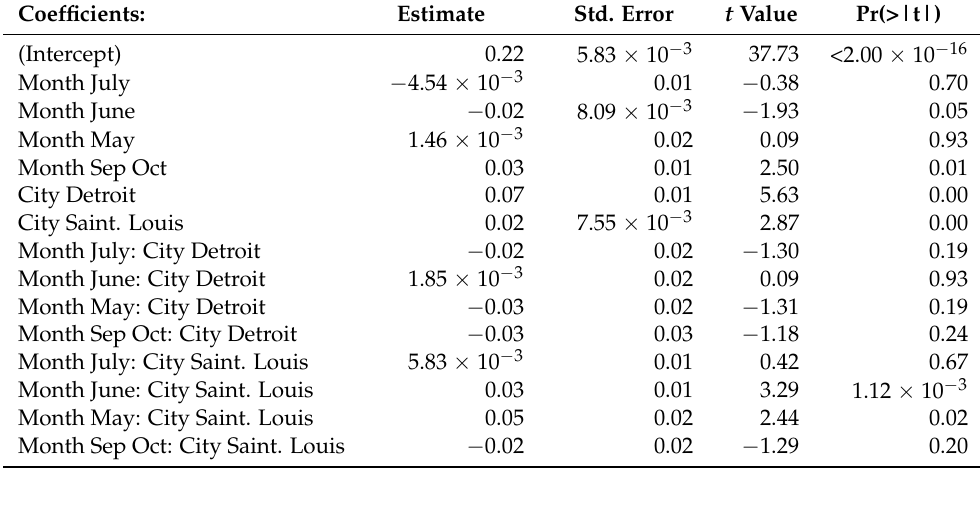
Table 4. The results of the linear model with head width as the response variable and month and city as interacting fixed effects indicate significant relationships between bee head with and city climate.